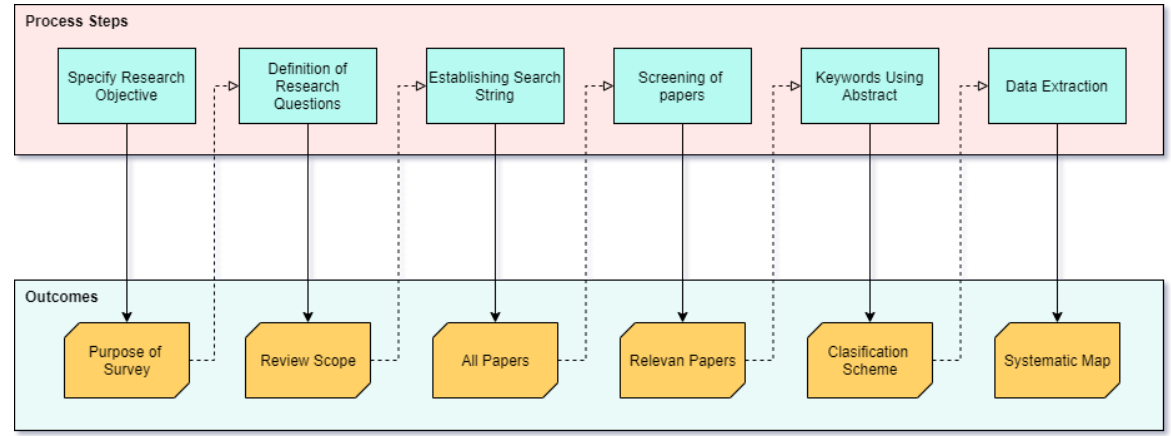
Figure 2. Stages of systematic mapping.